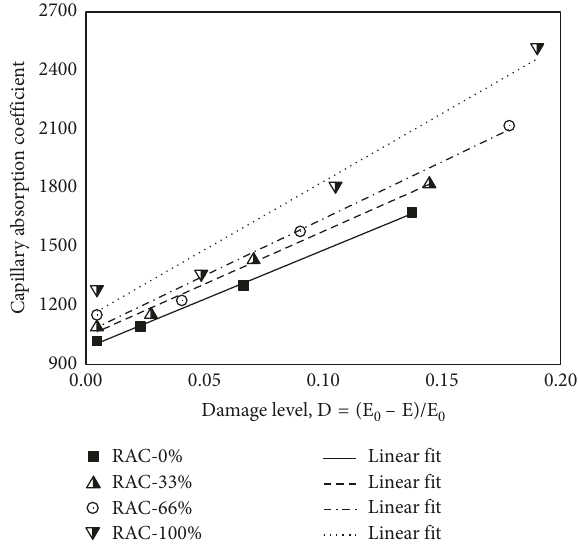
Figure 12: Correlation between capillary absorption coefficient and imposed load damage